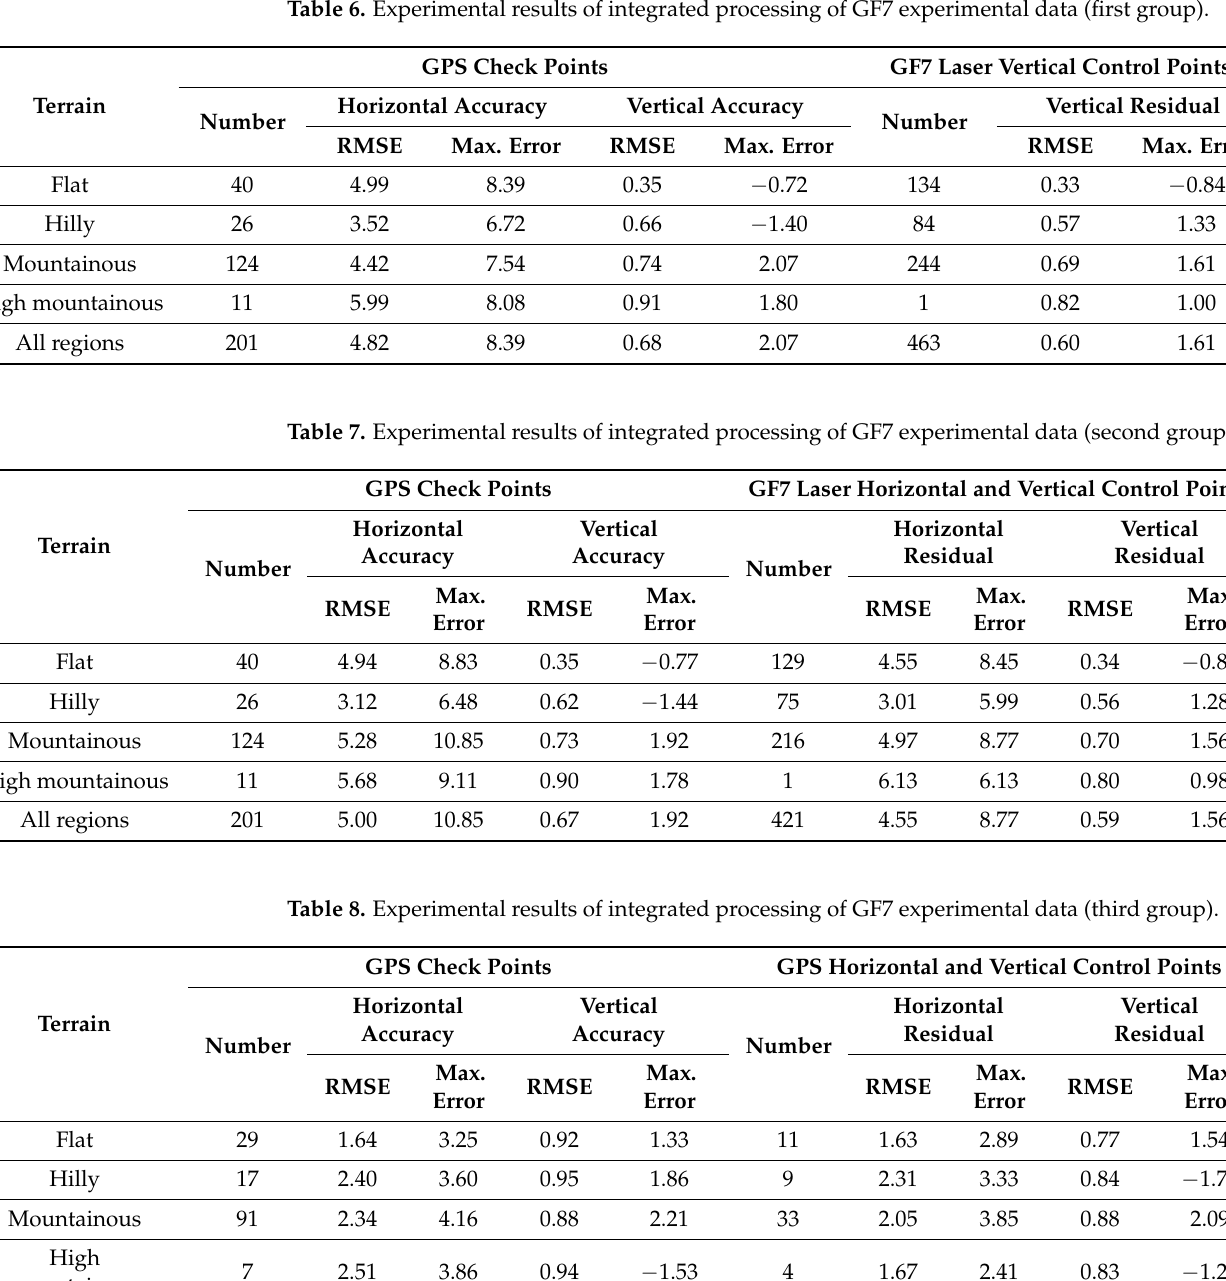
Table 6. Experimental results of integrated processing of GF7 experimental data (first group).